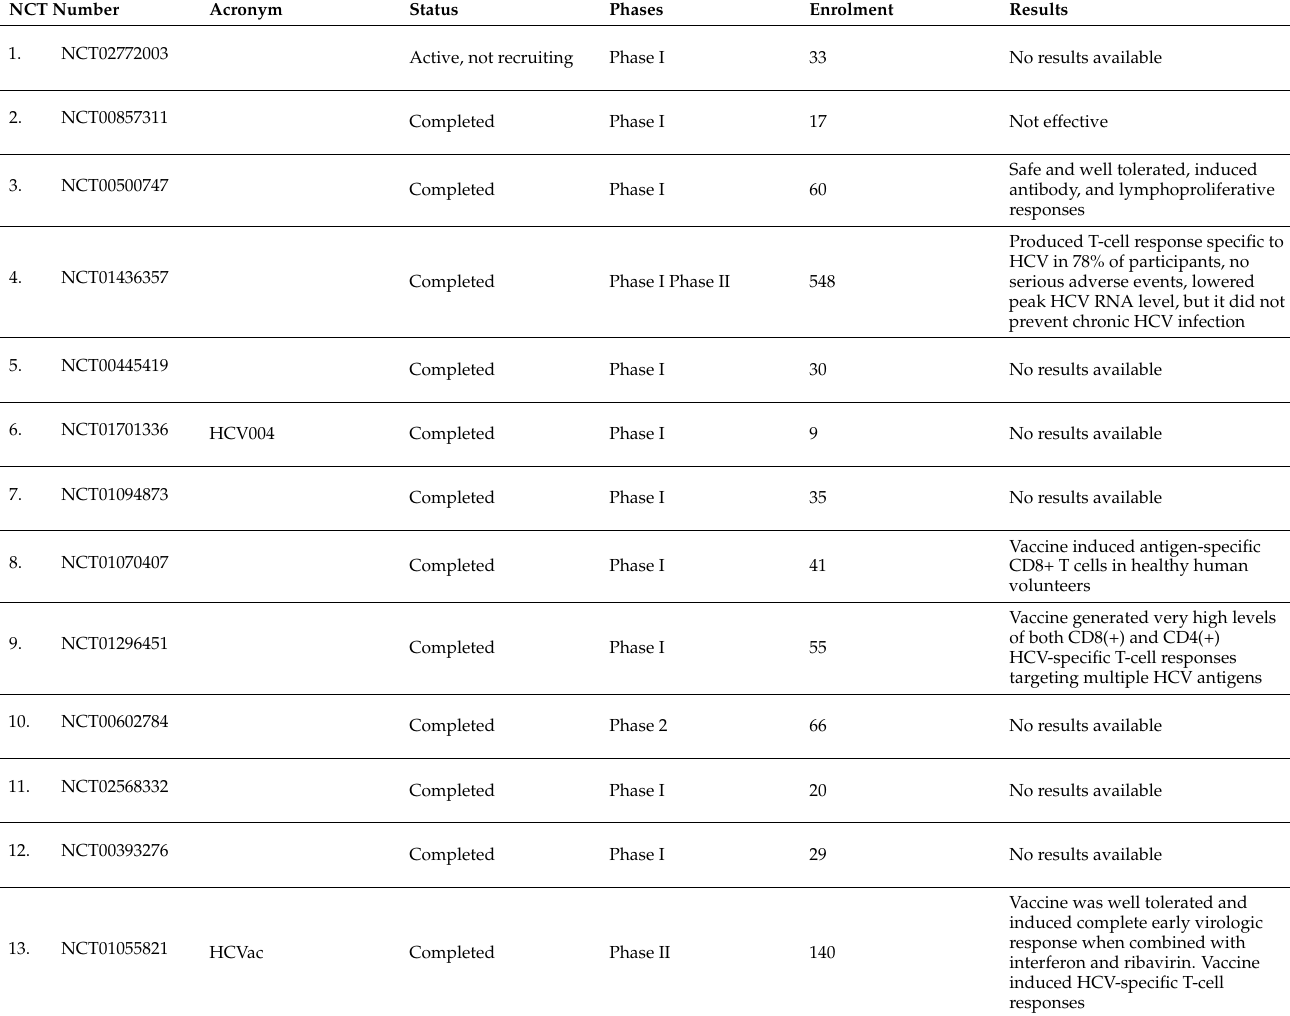
Table 1. Current and past trials for hepatitis C vaccinations